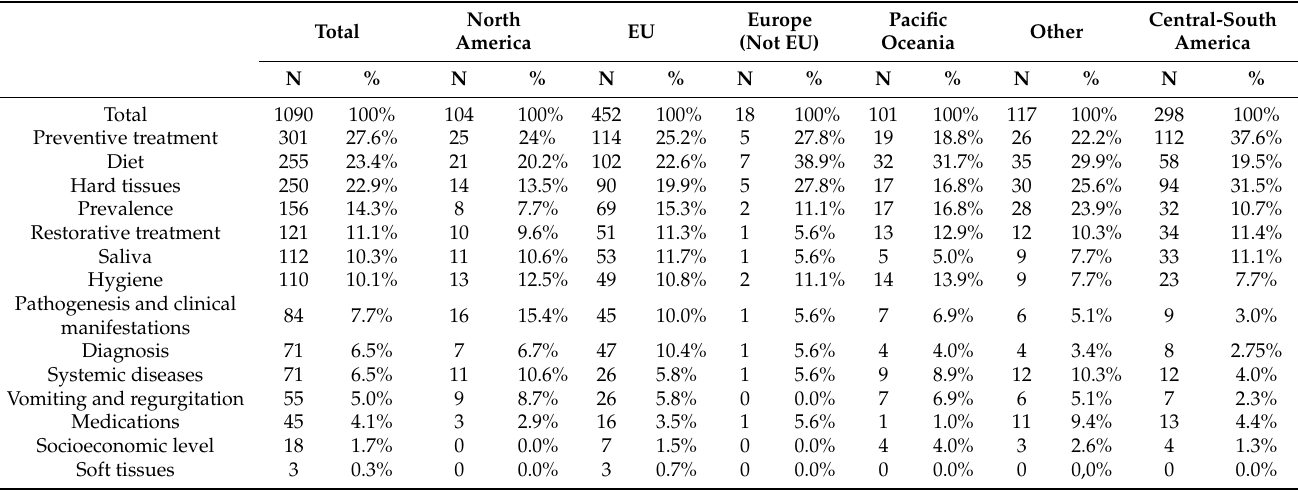
Table 2. Distribution of the topics regarding the geographic